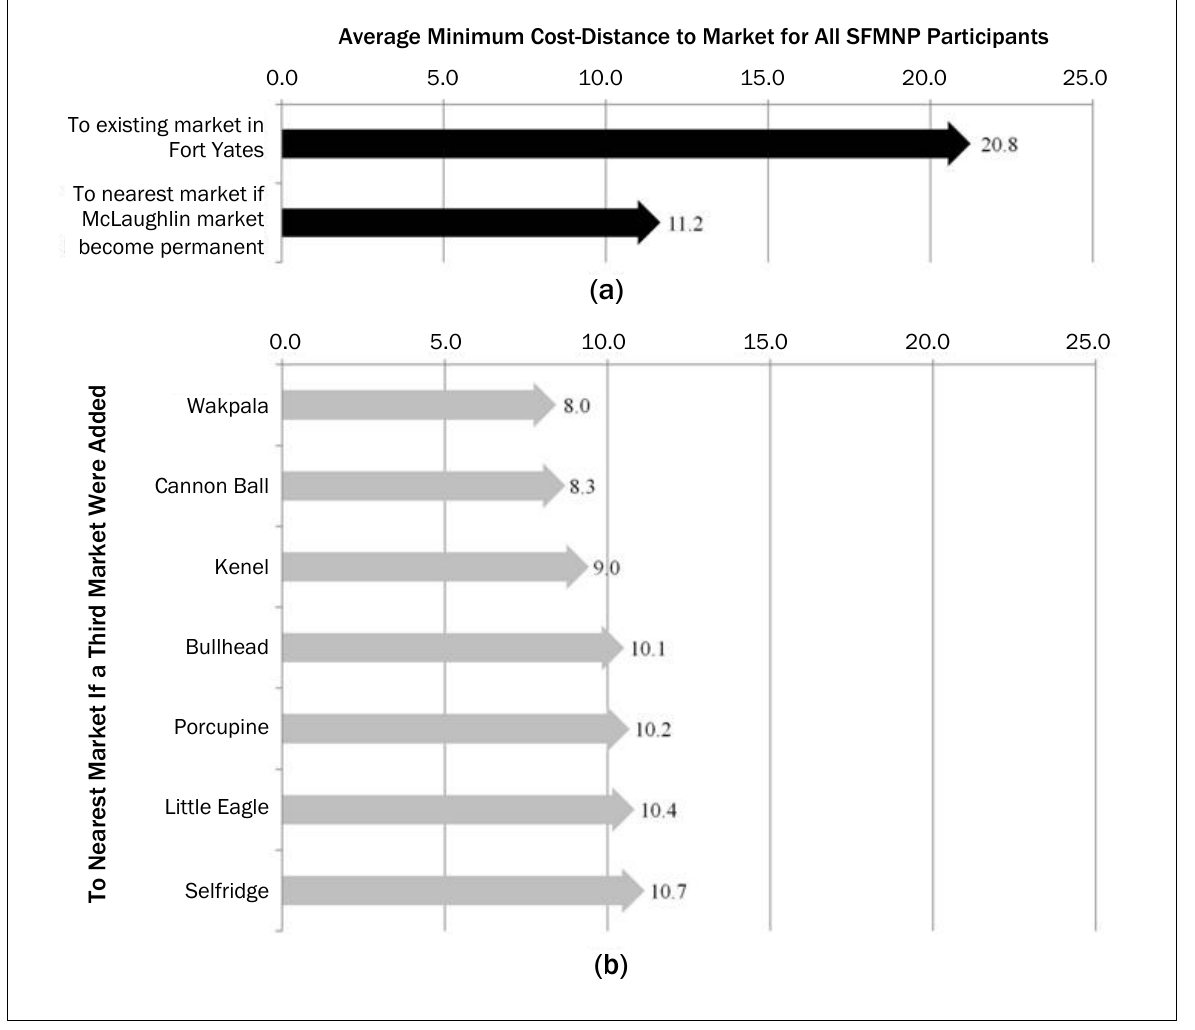
Figure 5. Predicted Changes in Average Cost-Distance to Market Following the Addition of New Markets